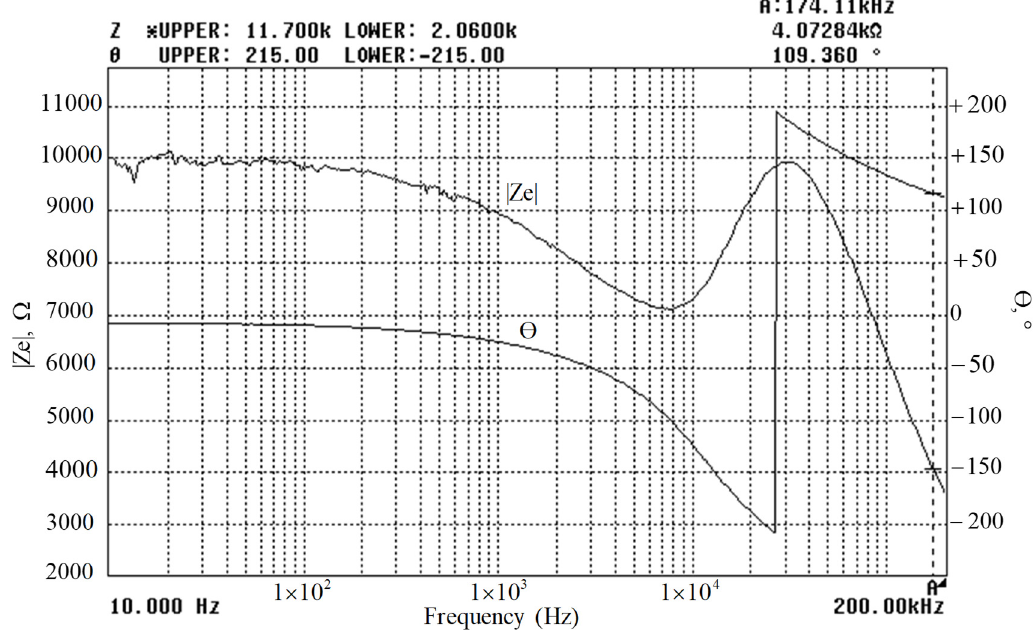
Figure 1. Impedance Z and phase angle θ against frequency for a sample